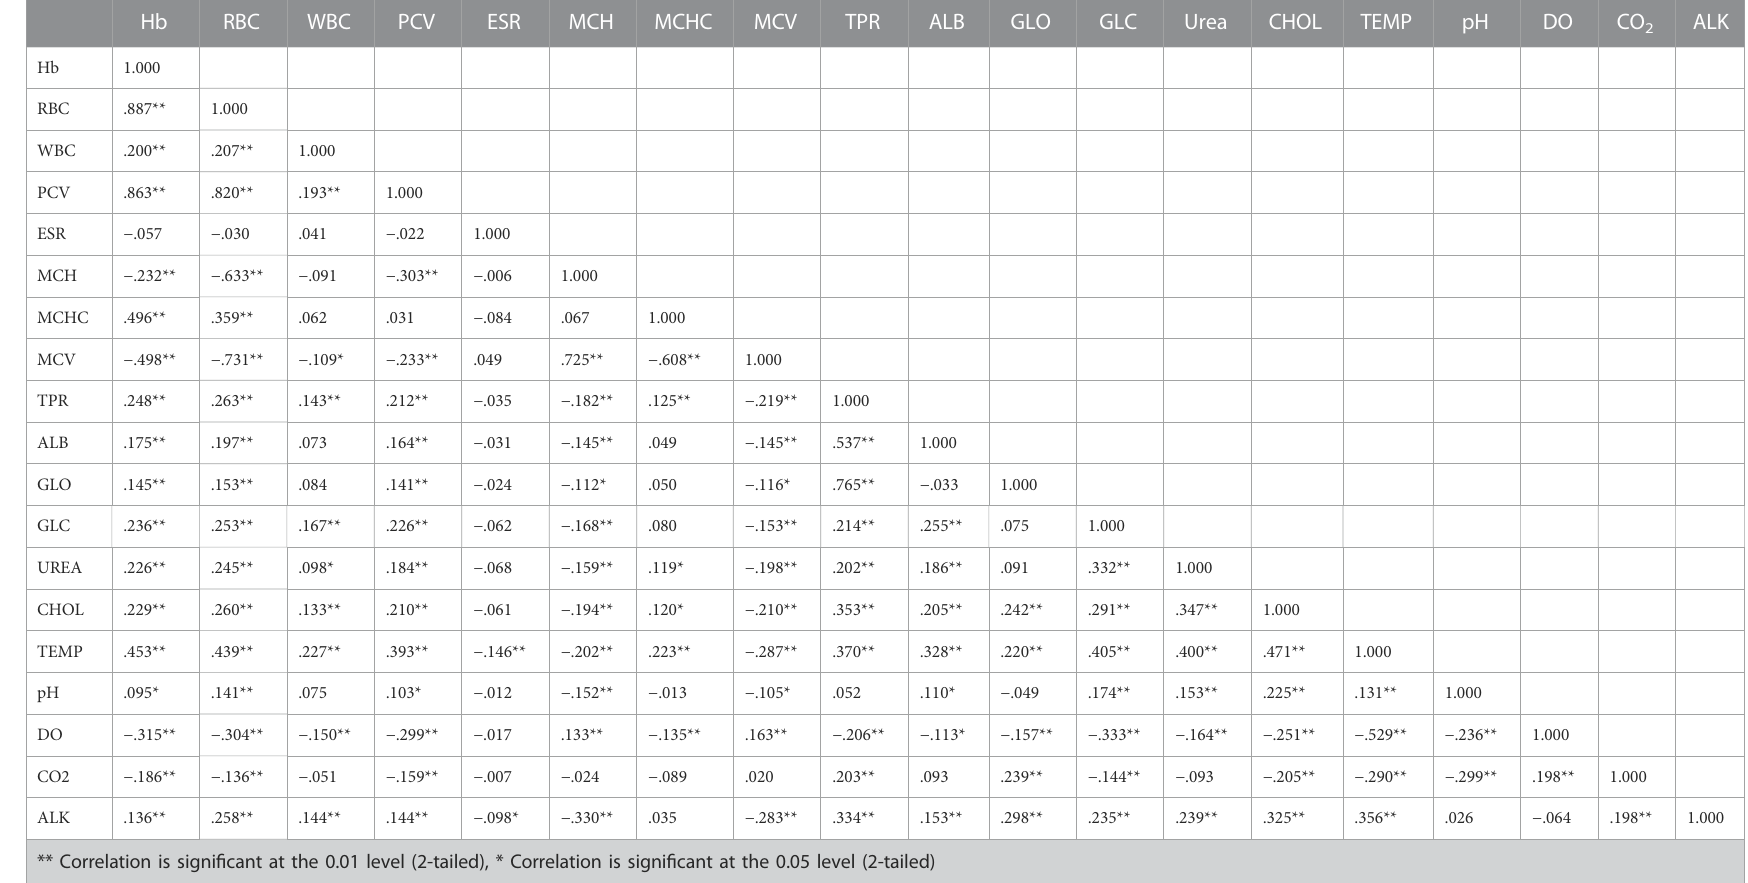
TABLE 4 Correlation matrix of blood analytes of S. esocinus and physico-chemical parameters from River Jhelum. Hb RBC WBC PCV ESR Hb